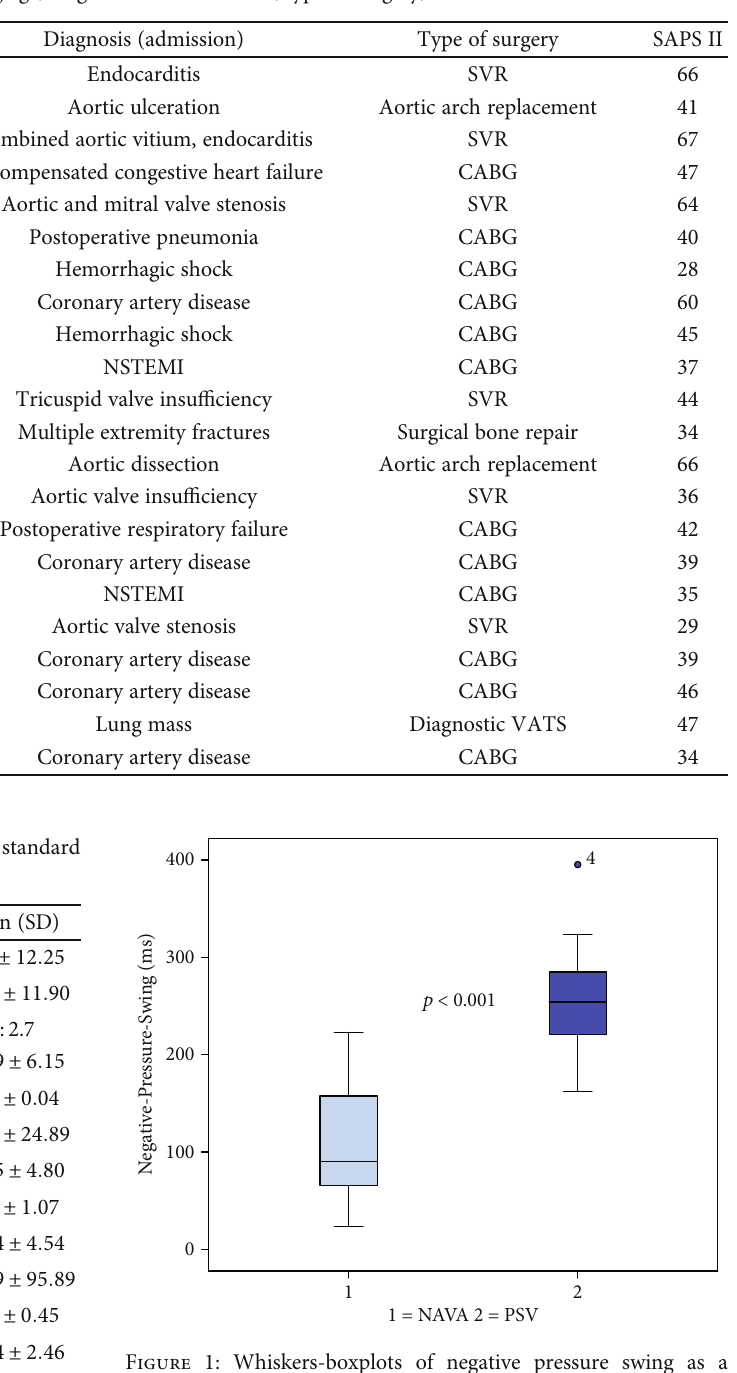
Table 1: Individual patient characteristics including age, diagnosis ICU admission, type of surgery, and SAPS II on admission.